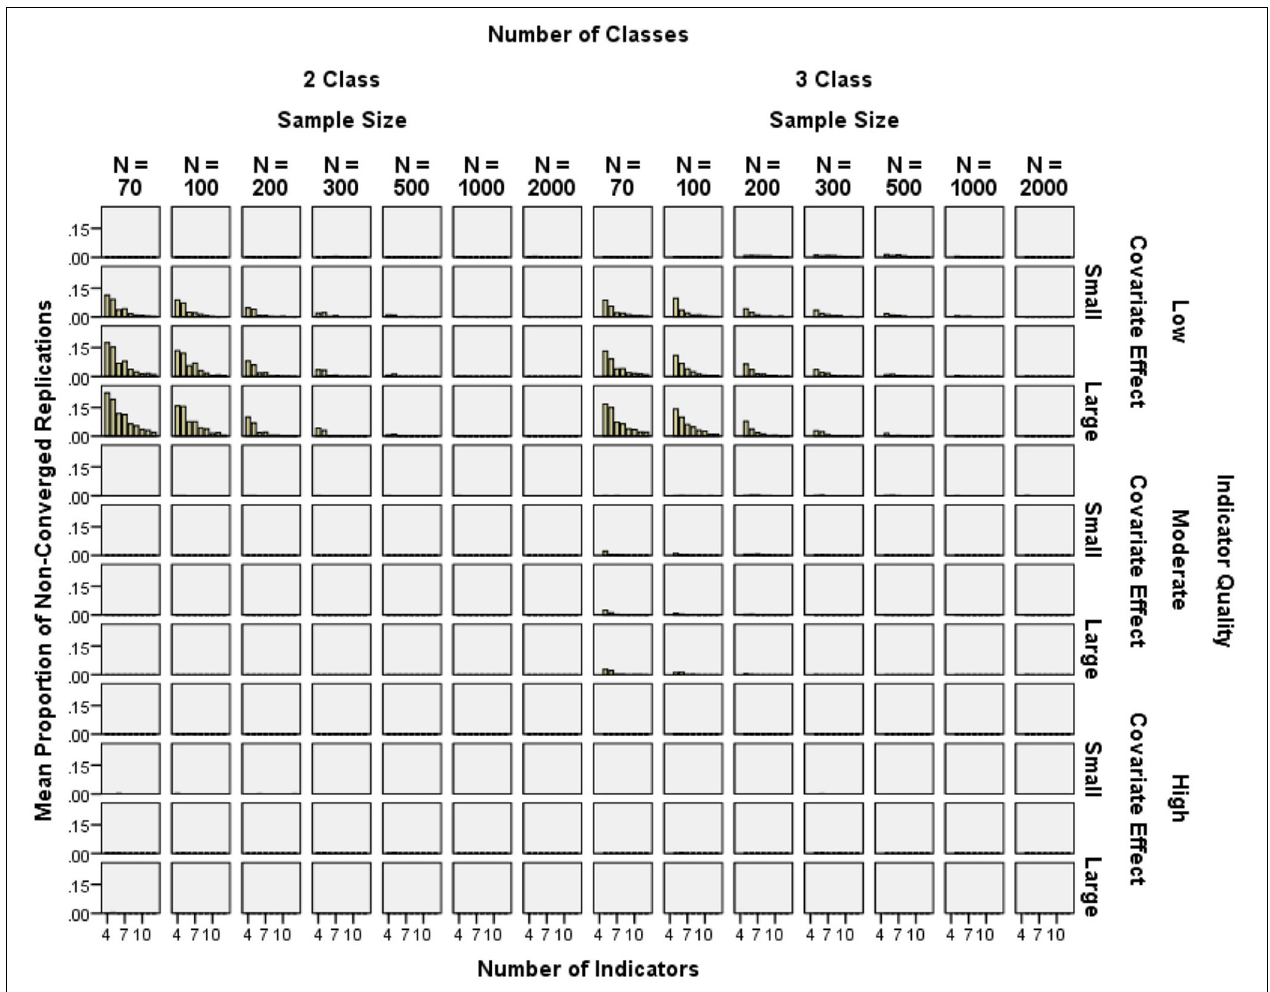
FIGURE 3 | Mean proportion of non-converged replications by sample size, number of indicators, and covariate effect size for high and low quality indicators.